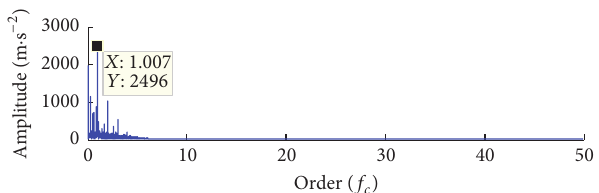
Figure 6: The waveform of the signal component with the largest energy.